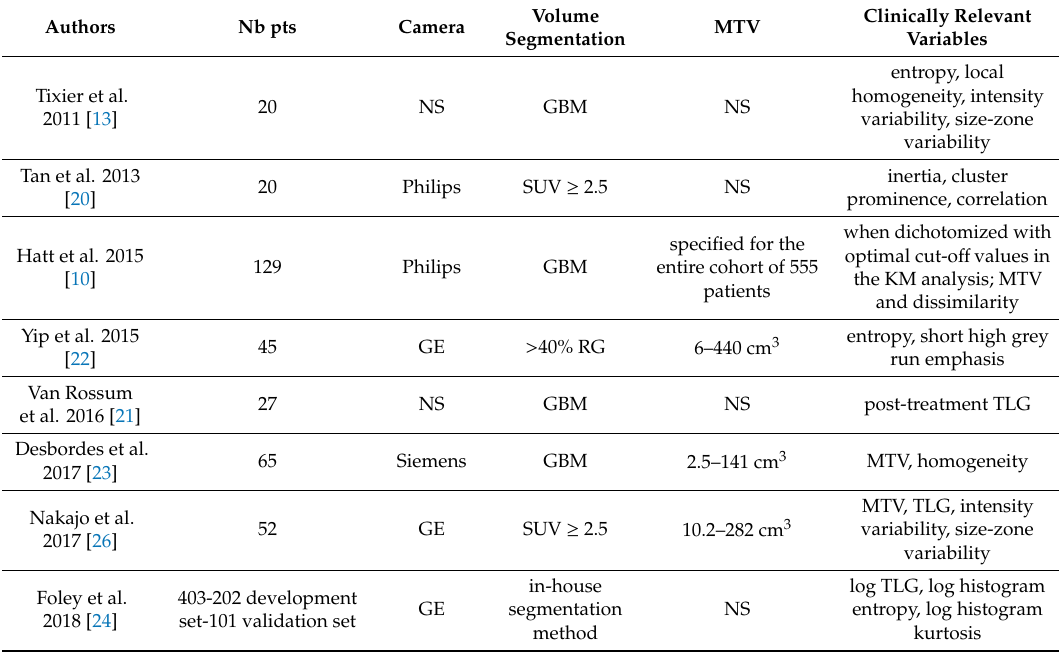
Table 1. Studies investigating texture analysis in esophageal carcinoma